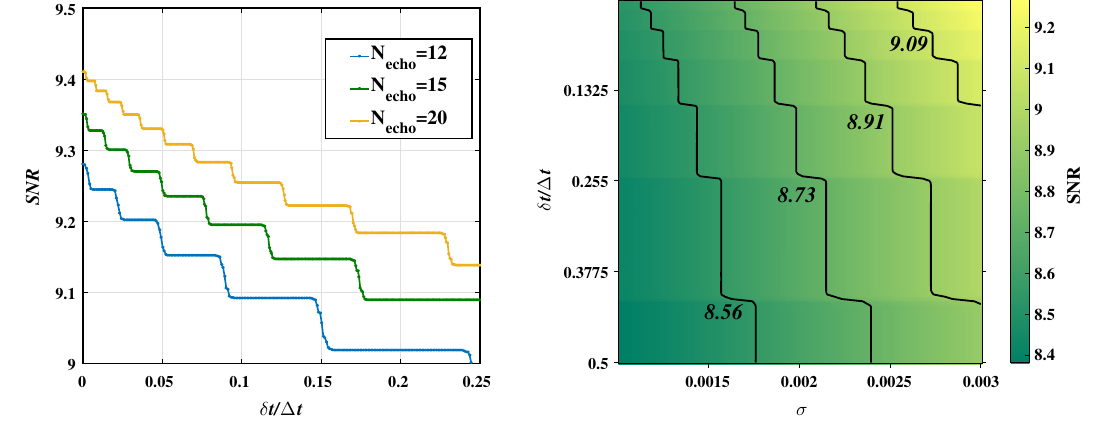
Fig. 3 Left panel: the SNR with respect to δ t /(cid:11) t for different N echo . Right panel: the SNR with respect to σ and δ t /(cid:11) t , we fix N echo = 12